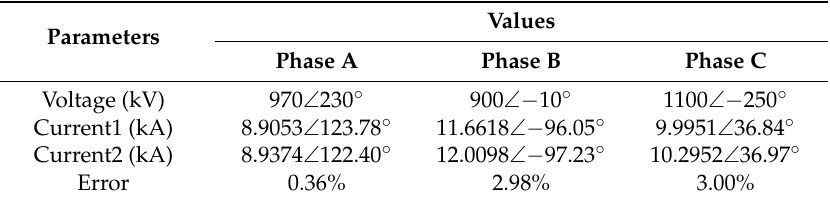
Table 5. Measured currents at the third group of